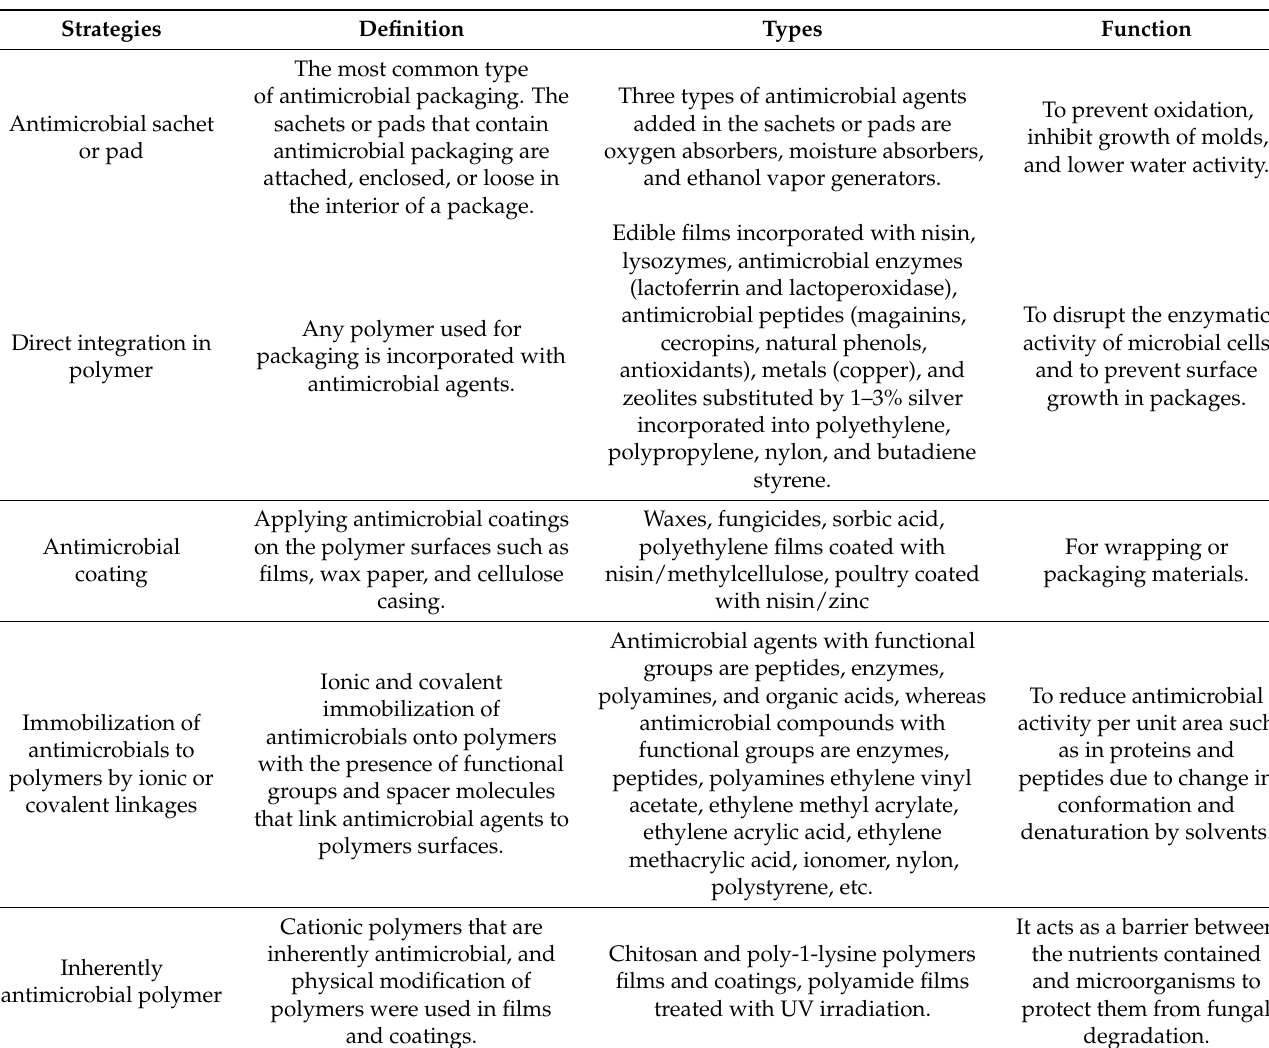
Table 3. Description of antimicrobial packaging